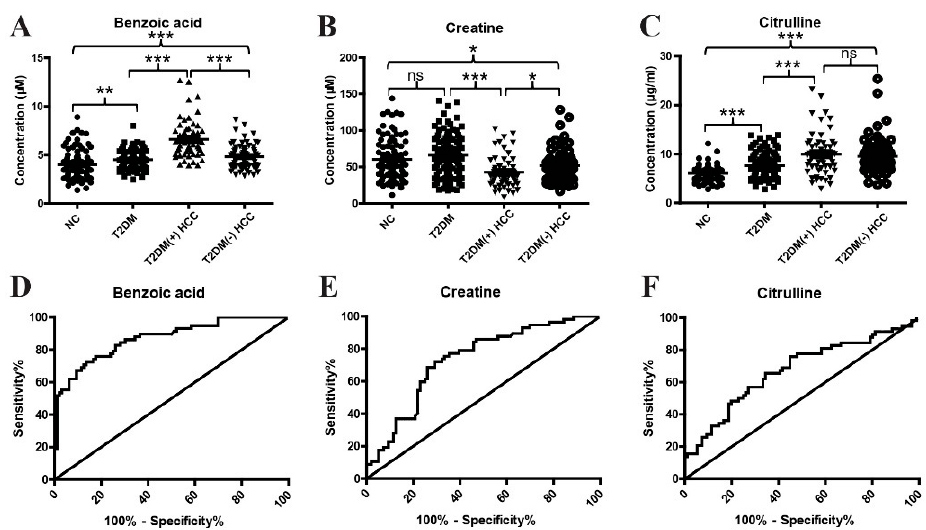
Figure 4. The expression profiles of several dysregulated metabolites in the discovery cohort. ( A ) The levels of serum benzoic acid in the discovery cohort. ( B ) The levels of serum glyceric acid in the discovery cohort. ( C ) The levels of serum creatine in the discovery cohort. ( D ) The levels of serum L-threonine in the discovery cohort. ( E ) The levels of serum citrulline in the discovery cohort. *** p value < 0.001; ns, not significant.